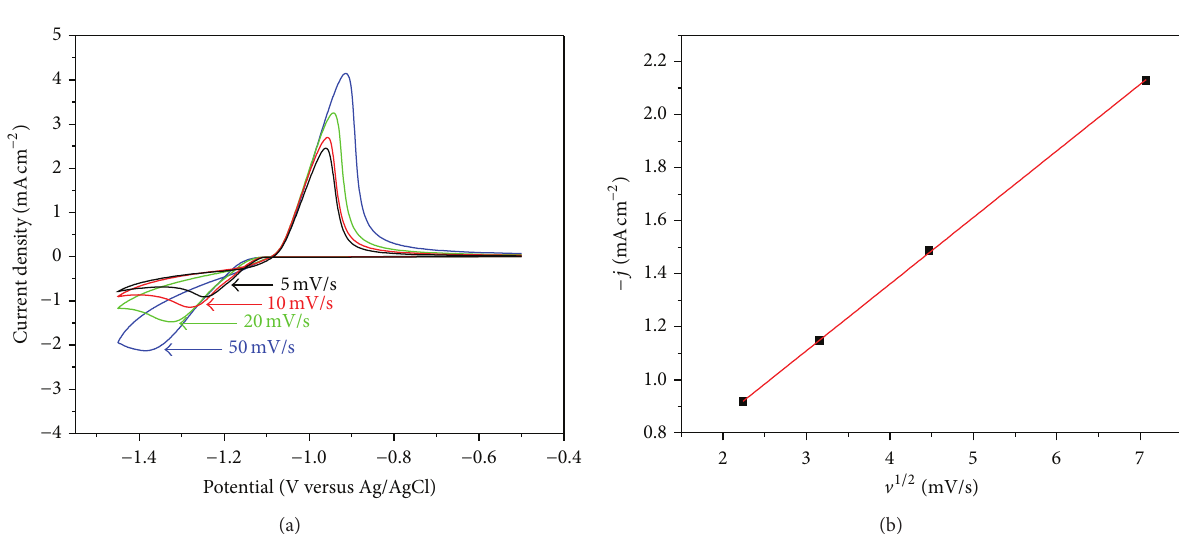
Figure 3: (a) X-ray patterns and (b) EDAX spectra of Zn deposits.